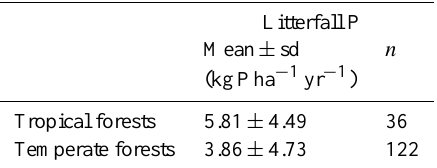
Fig. 3. Fractions of different soil P expressed as a percentage of to- tal soil P. Slightly weathered soils: Andisols, Histosols, Entisols, In- ceptisols; Intermediately weathered soils: Aridisols, Vertisols, Mol- lisols, Alfisols; Highly weathered soils: Ultisols, Spodosol, Oxisols. Table 3. Annual litterfall P flux in tropical, temperate forests. Litterfall